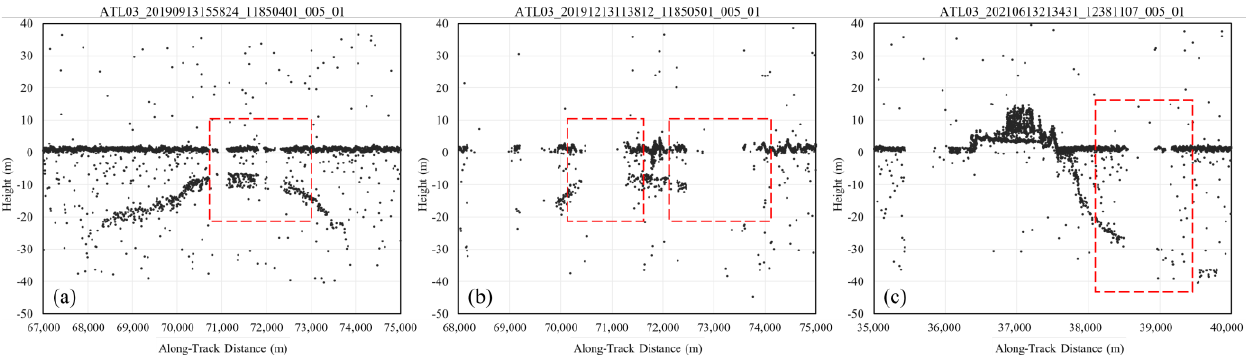
Figure 14. Three actual cases with missing ICESat-2 bathymetric signals, all located in the sea area near Dongdao Island. near Dongdao